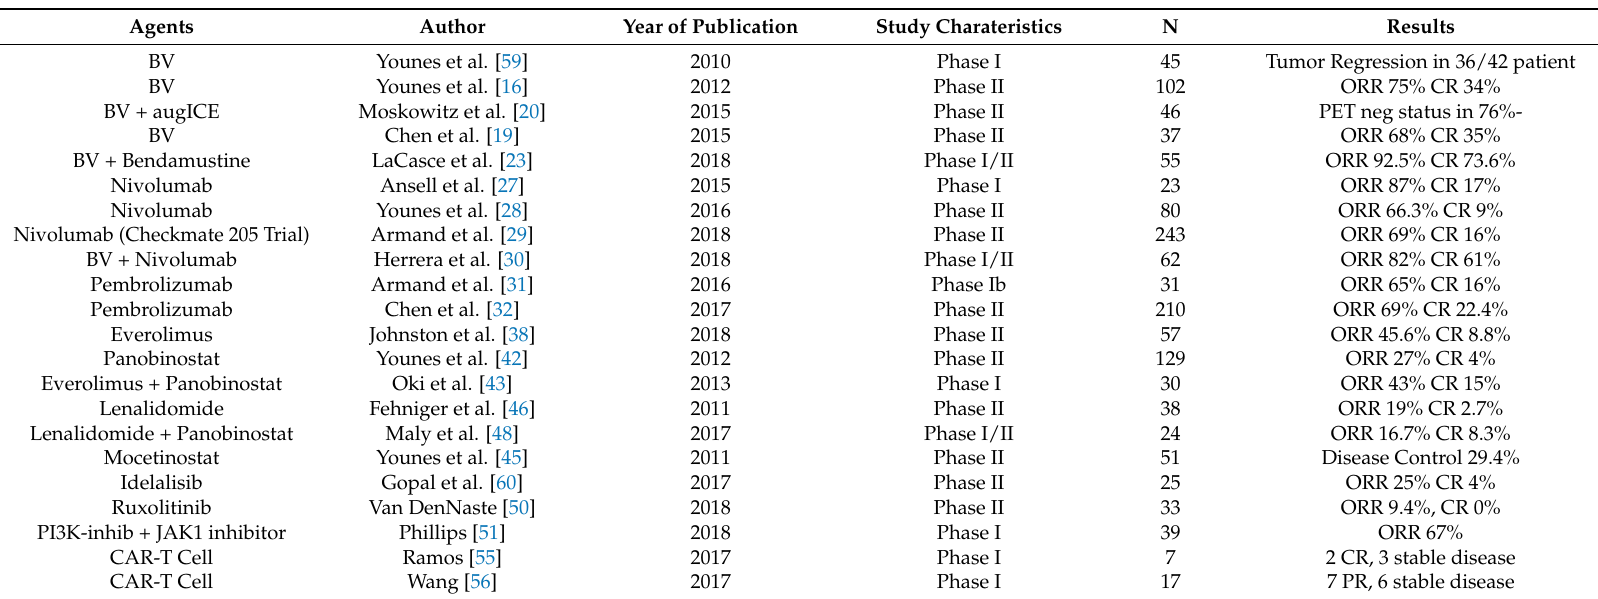
Table 1. Summary of different trials and novel approaches to relapsed/refractory